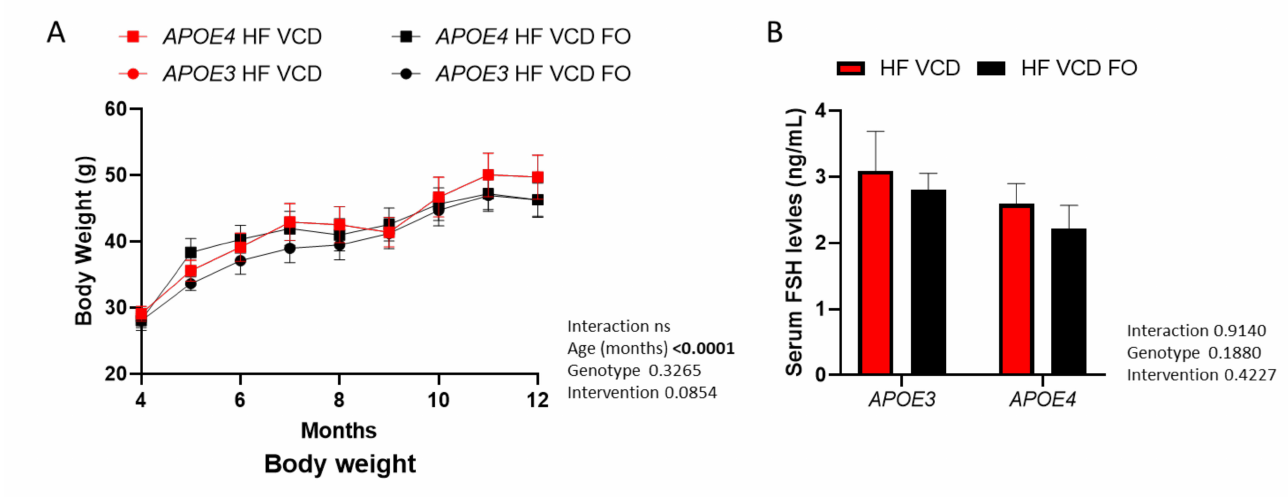
Figure 1. Effects of fish oil (FO) supplementation on body weight and follicle-stimulating hormone (FSH) levels. ( A ) Although body weight significantly increased as animals aged, it was not altered across genotype or FO supplementation (three-way ANOVA n ≥ 7). ( B ) Serum FSH levels remained unchanged by FO intervention. Data are presented as mean ±